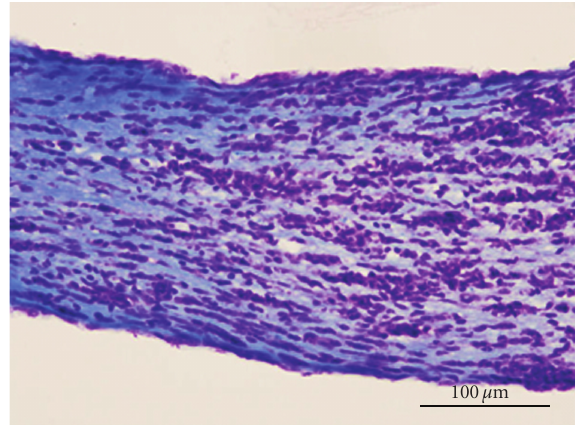
Figure 2: Luxol fast blue staining for myelin sheath in the optic nerve of a mouse adjuvant immunized with MOG peptide. Regions of weak staining of the myelin sheath corresponds to regions of cell infiltration in the optic